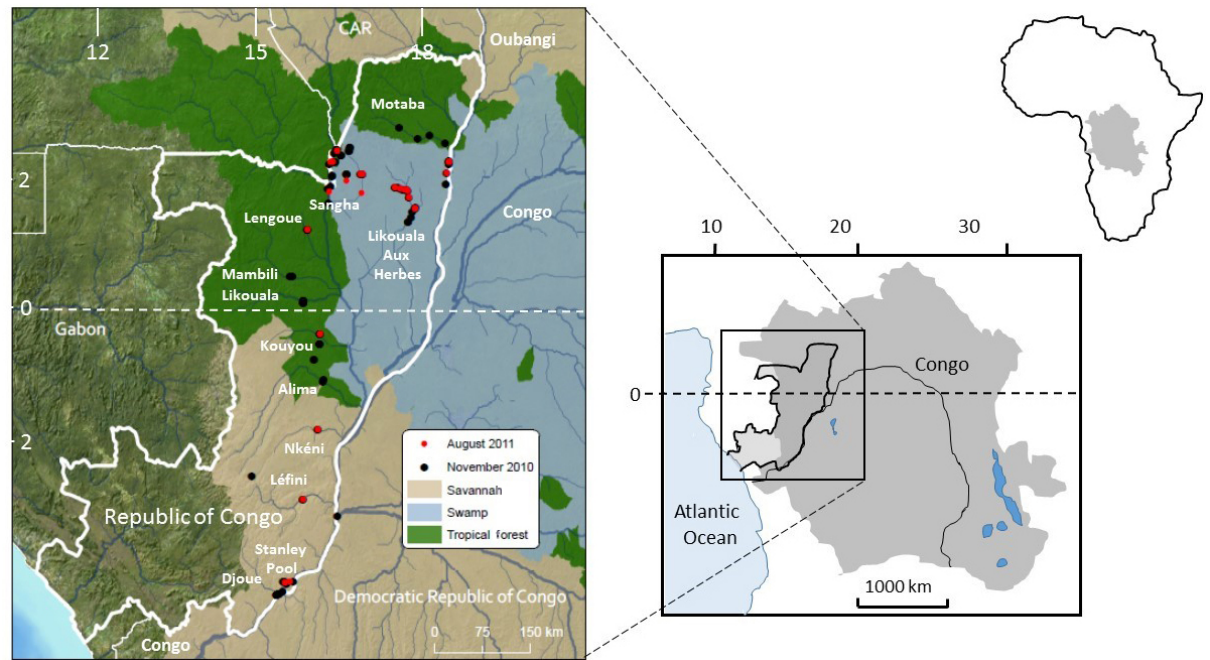
Figure 1. Locations of river sampling stations in the Republic of